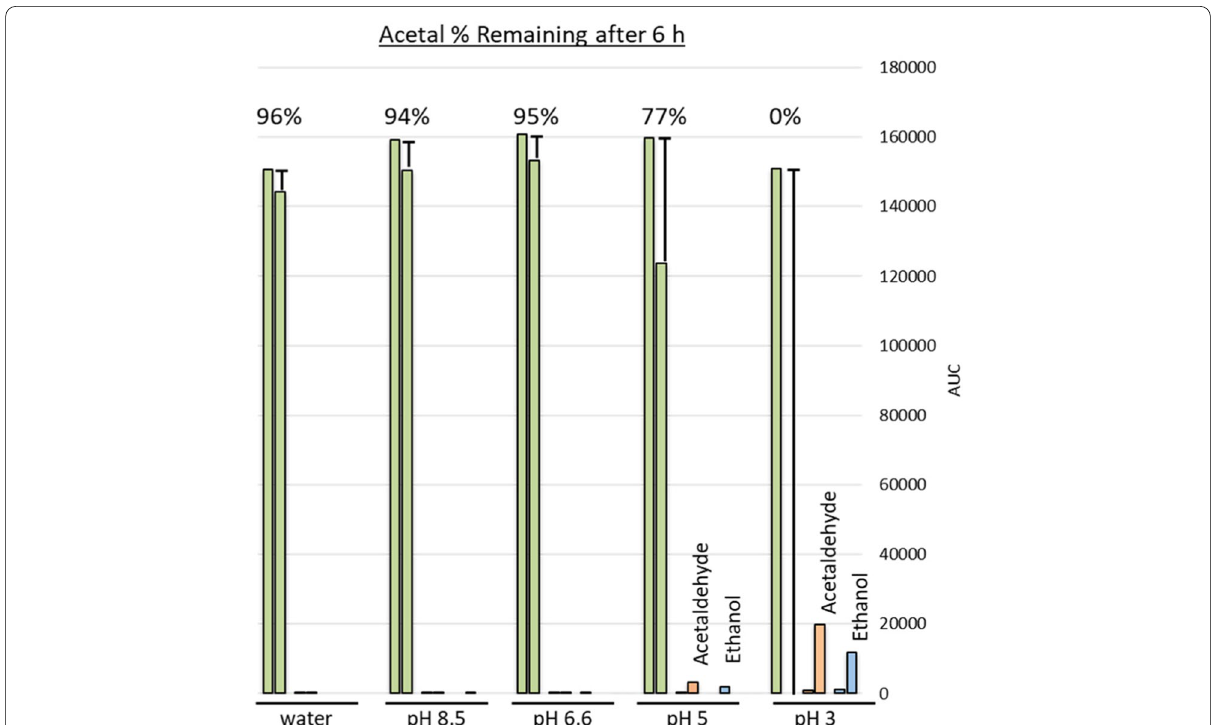
Fig. 2 Acetal unstable at pH < 5 during kinetic study*. *Acetal response is depicted in green at 0 h and 6 h. At pH 5 and pH 3, acetal response decreases rapidly and the formation of acetaldehyde (orange) and ethanol (blue) is observed. Acetal is stable in buffers at pH